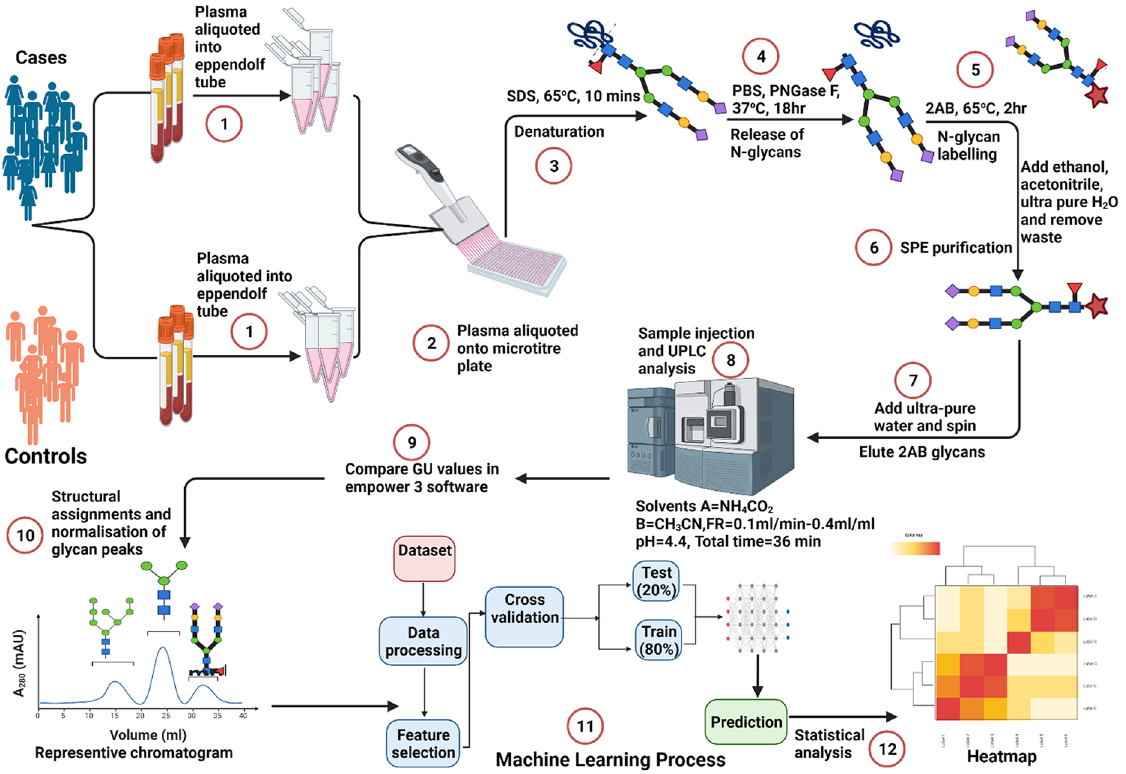
Figure 2. Workflow of N-glycan analysis with UPLC-FLR. Plasma samples were aliquoted into 96 well plates and denatured with sodium dodecyl sulphate (SDS). The plate was sealed and incubated at 65 °C for 10 min. IGEPAL CA-630 was added and sample mixed by pipetting up and down. This was then followed by incubation at room temperature. Glycans were freed from their bound glycoproteins by adding peptide N-glycosidase F (PN-Gase F) and incubation at 37 °C for 18 h. glycans were then fluorescently labelled with 2-aminobenzamide and incubated for 2 h at 65 °C. This was followed by four-step washing procedure with acetonitrile and 2AB pH = 4.4. Structural assignments and normalisation of glycan peaks were then